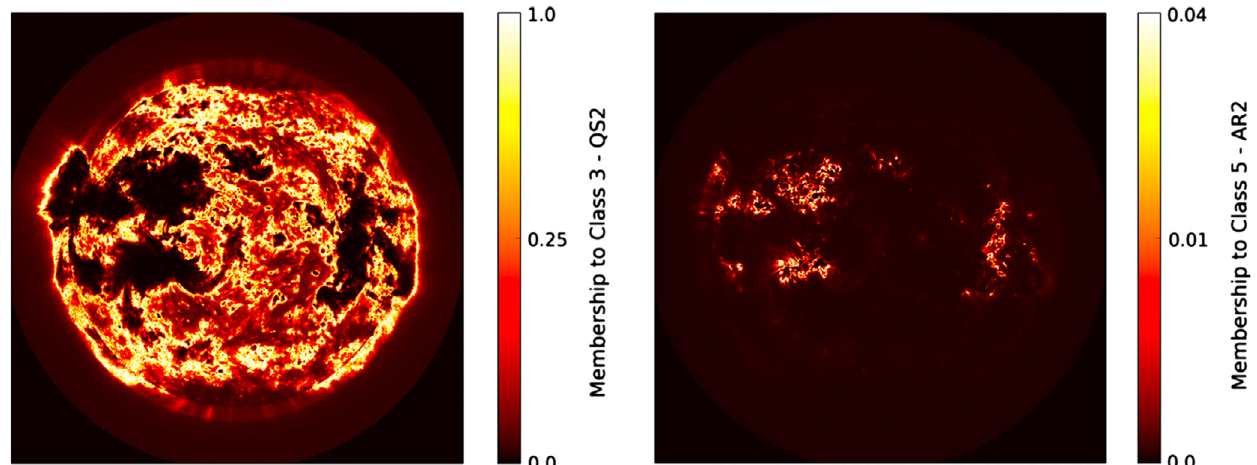
Fig. 3. Maps of the membership values for the coronal quiet network (QS2, left panel) and active regions (AR2, right panel) corresponding to a 171 Å image taken on 23